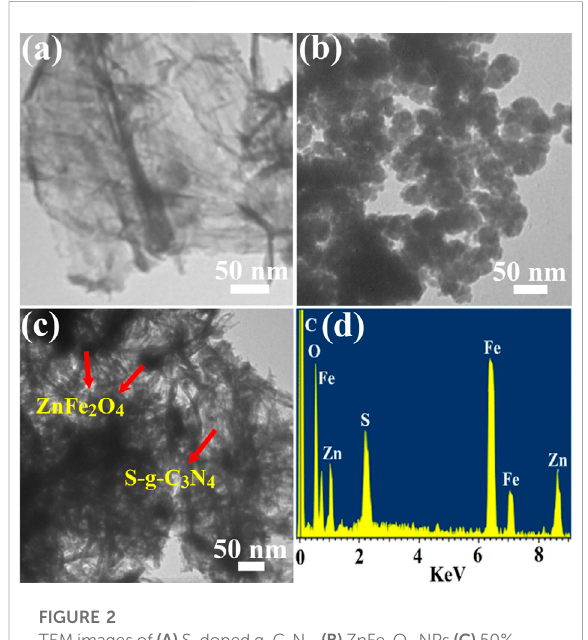
FIGURE 2 TEMimagesof (A) S-dopedg-C 3 N 4 , (B) ZnFe 2 O 4 NPs (C) 50% ZnFe 2 O 4 /S-g-C 3 N 4 NCs and (D) shows the EDX of 50% ZnFe 2 O 4 / S-g-C 3 N 4